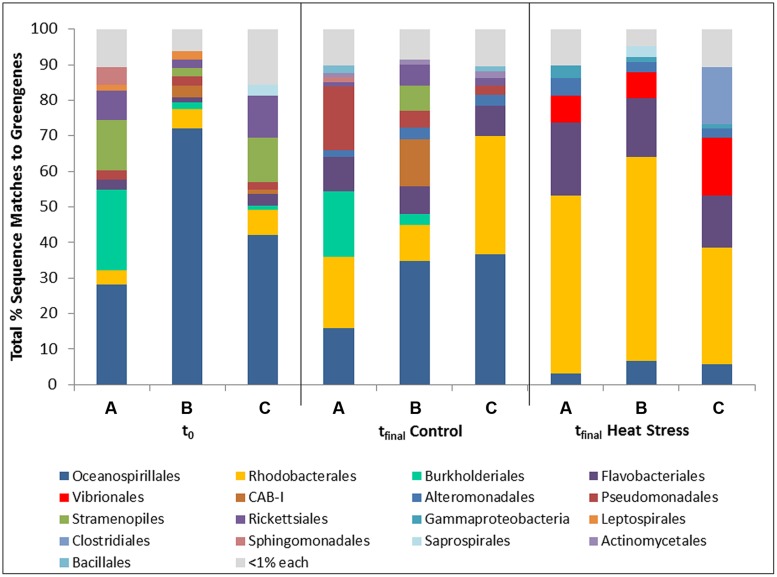
Bacterial taxa (order) associated with the coral Pocillopora damicornis on Heron Island, the Great Barrier Reef at t0 (22°C; A–C are replicates), tfinal Control (22°C; A–C are replicates), and tfinal Heat stress (31°C; A–C are replicate nubbins) conditions using 16S rRNA gene amplicon sequencing. Hits were generated by comparing the sequences with BLASTn to the Greengenes database in QIIME.